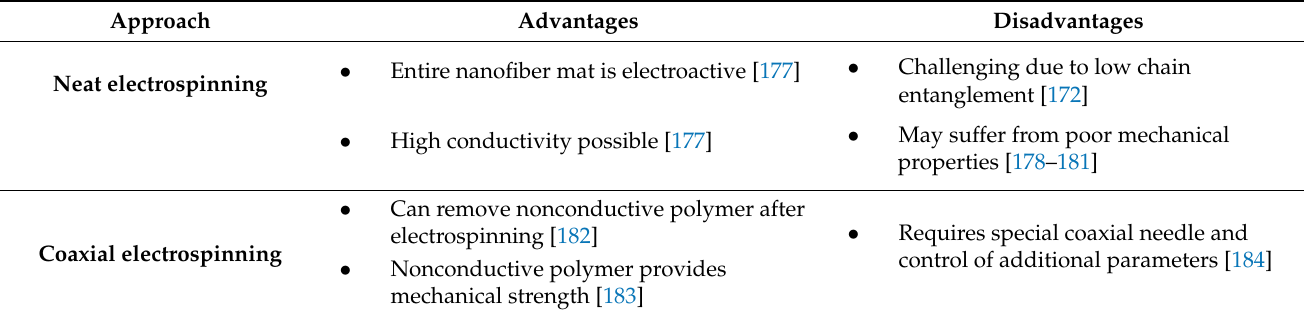
Table 1. Advantages and disadvantages of approaches to preparation of CP nanofibers.